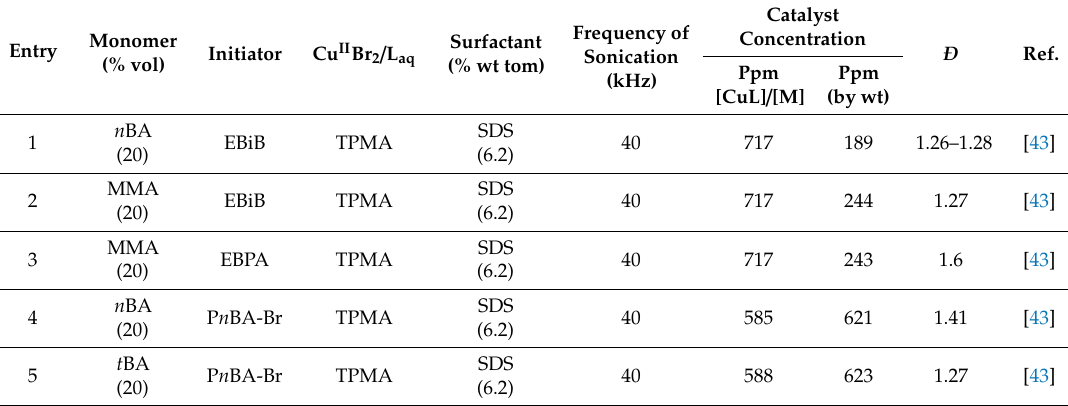
Table 4. Sono-ATRP in miniemulsion with di ff erent catalysts and monomers a